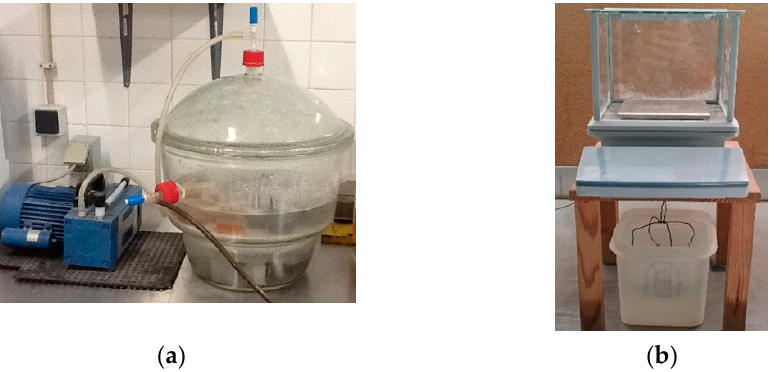
Figure 4. Set-up of open porosity test: ( a ) Desiccator to create vacuum; ( b ) Hydrostatic weighing apparatus.